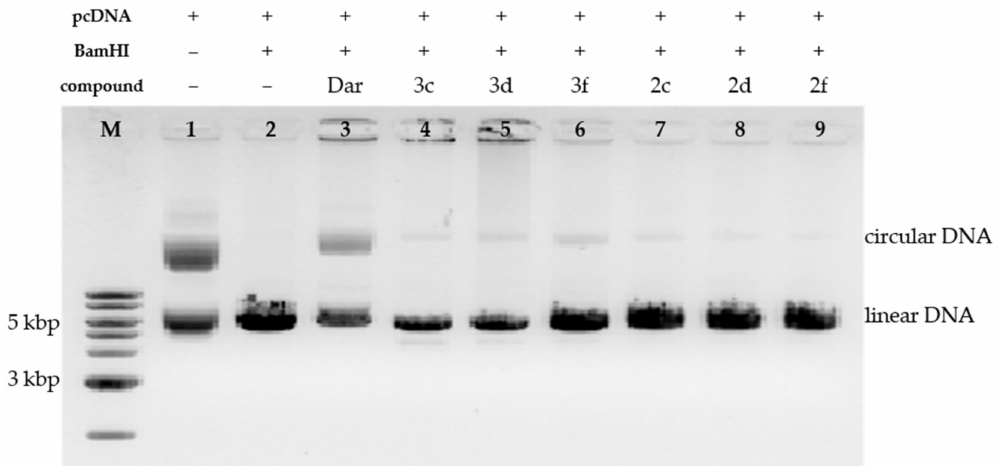
Figure 5. Effect of dicarboximides on digestion of pcDNA3.1HisC (total length 5.5 kbp) with BamH1 endonuclease observed by agarose gel electrophoresis. M—marker DNA;